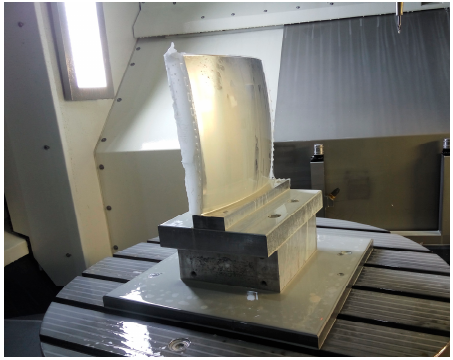
Figure 9. Freeform component after one surface machining was completed.